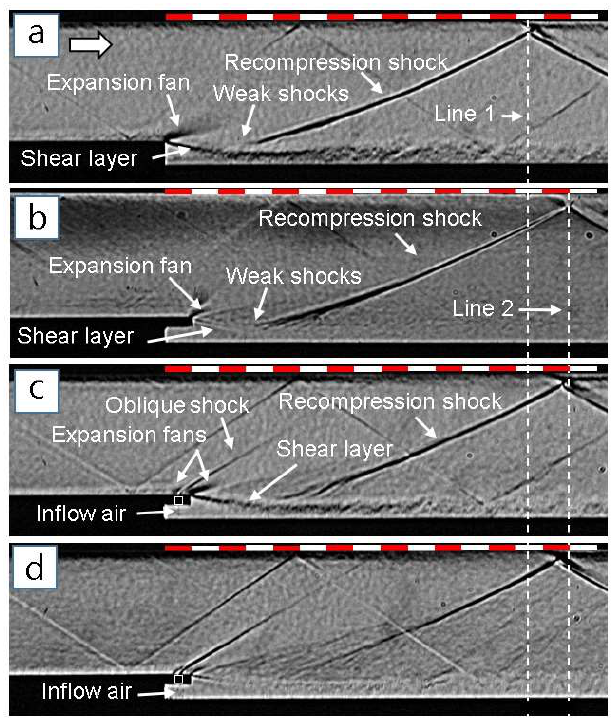
Figure 3. Flow field of various mixer models: ( a ) step mixer, ( b ) step mixer with an extended block, ( c ) vent circle mixer, and ( d ) vent slot mixer.